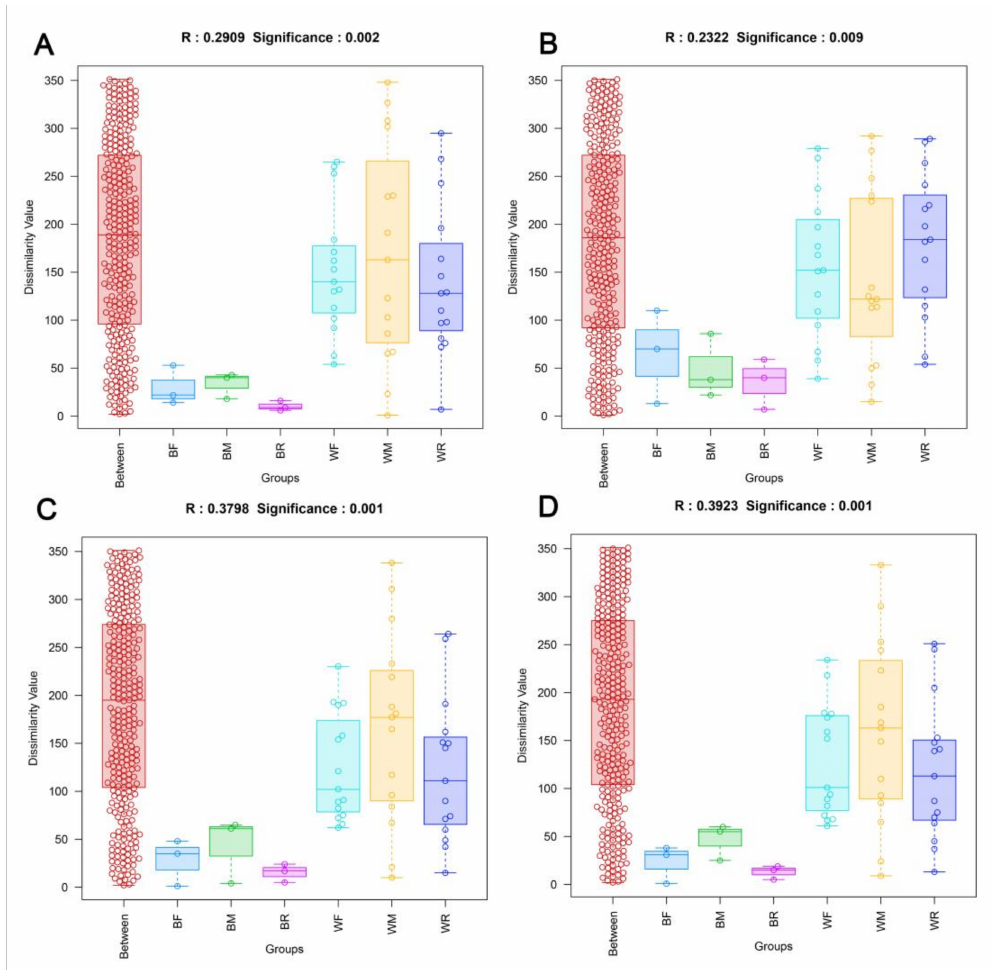
Figure 2. ANOSIM analysis at the OTU ( A ), phylum ( B ), family ( C ) and genus ( D ) levels of gut microbiota composition in cultivated and wild Mastacembelus armatus .